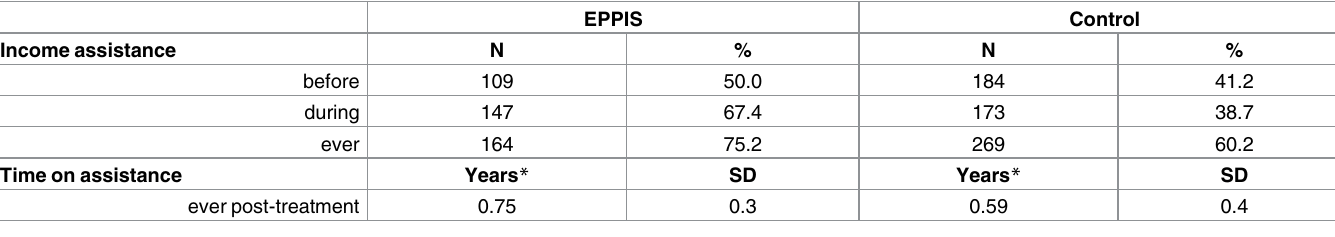
Table 3 contains descriptive data on the use of income assistance. Before initiation of treatment, the EPPIS group had a slightly higher rate of income assistance (50% versus 41 (cid:1) 2%), but this difference increased during the treatment period (67 (cid:1) 4% versus 38 (cid:1) 7%). Table 4 shows the results of the regression analyses for income assistance use post-treatment. The EPPIS Table 3. Use of income assistance by EPPIS and control